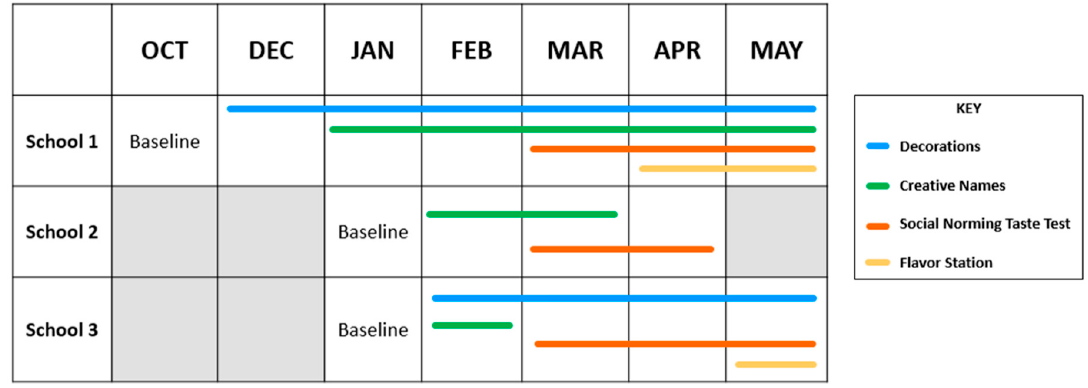
Figure 1. Timeline of intervention components implemented at School 1, 2, and 3. OCT: October; DEC: December; JAN: January; FEB: February; MAR: March; APR: April.